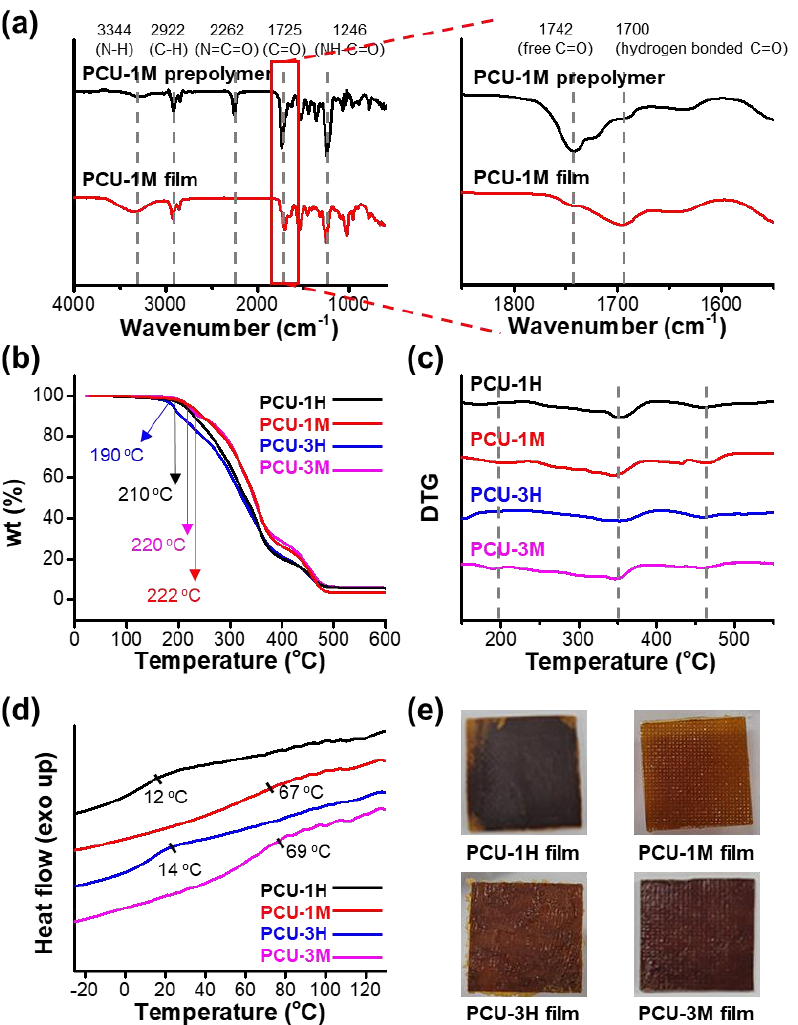
Figure 2. ( a ) Fourier transform infrared analysis of the PCU-1M prepolymer powder and the hot- pressed film, showing the complete conversion of the starting materials; ( b ) The TGA curves of films; ( c ) The DTG curves of the PCU films; ( d ) The DSC curves of the PCU films and the corresponding T g s; ( e ) Photographs of the PCU films after the hot-pressing process.